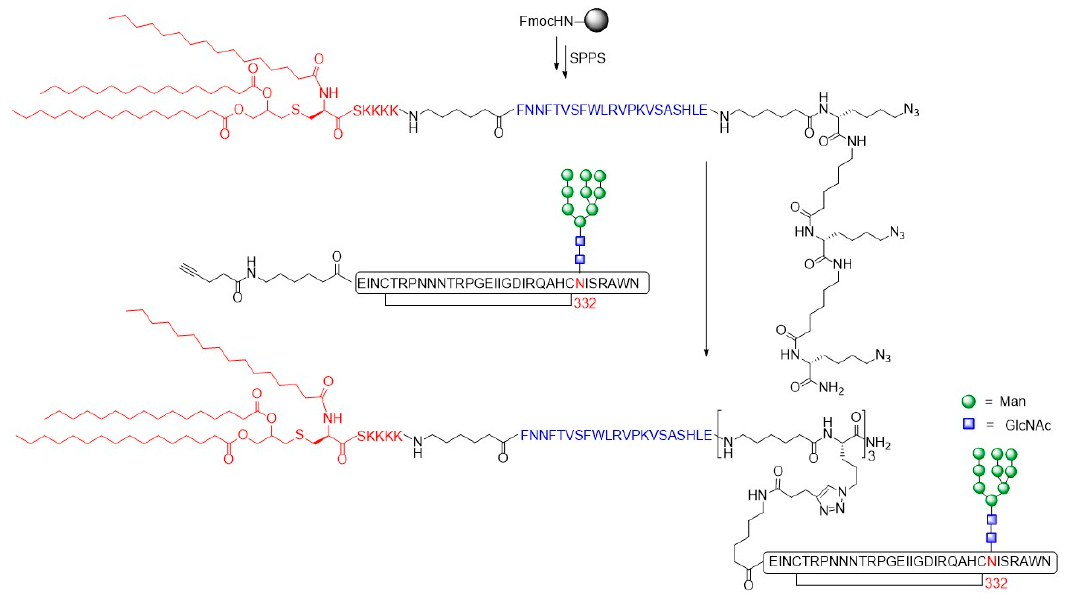
Figure 14. Design of the three-component trivalent HIV-1 vaccine construct.